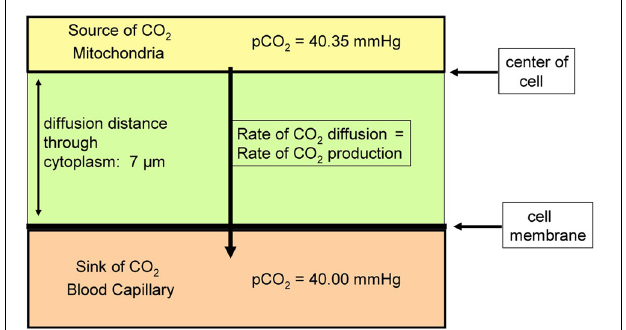
FIGURE 3 | Scheme of the model used to estimate the effect of membrane CO 2 permeability on the release of CO 2 from a cardiomyocyte. CO 2 diffuses from the CO 2 source located in the center of the cell first through the cytoplasm, and then through the plasma membrane, into the blood